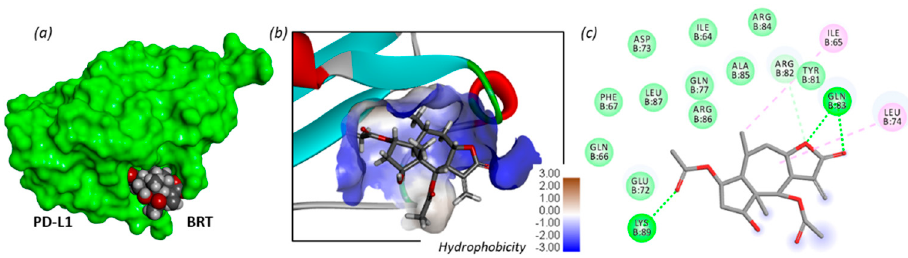
Figure 7. Molecular model of BRT bound to PD-L1 (PDB structure 5O4Y). ( a ) BRT binding to PD-L1 (in green). ( b ) A detailed view of a stick model of BRT binding to PD-L1, with the hydrophobic zone surrounding the biding site (color code indicated). ( c ) Binding map contacts for BRT bound to PD-L1 (green dashed lines correspond to H-bonds). The site is centered around residue Ile-64 of PD-L1. Calculated potential energy of interaction Δ E: − 56.50 kcal/mol.